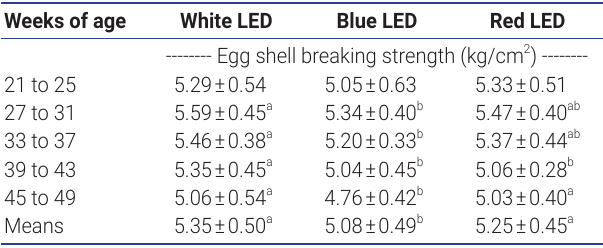
Table 3. The egg laying performance of Brown Tsaiya ducks in differ- ent treatment groups Weeks of age White LED Blue LED